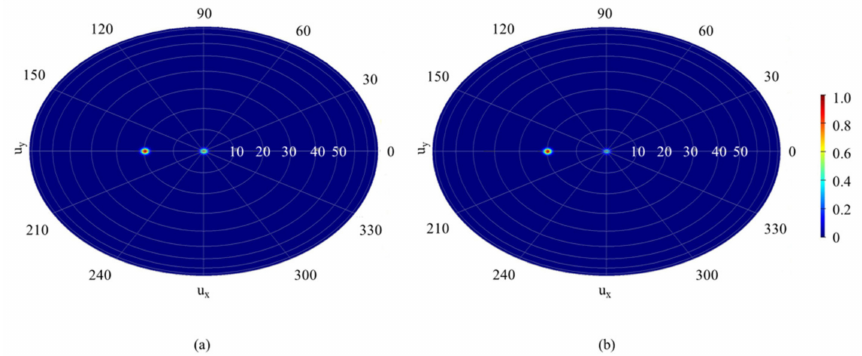
Figure 9. Full-wave simulation far field results of the beam steering metasurface for ( a ) 90 ◦ and ( b ) 45 ◦ phase gradients.